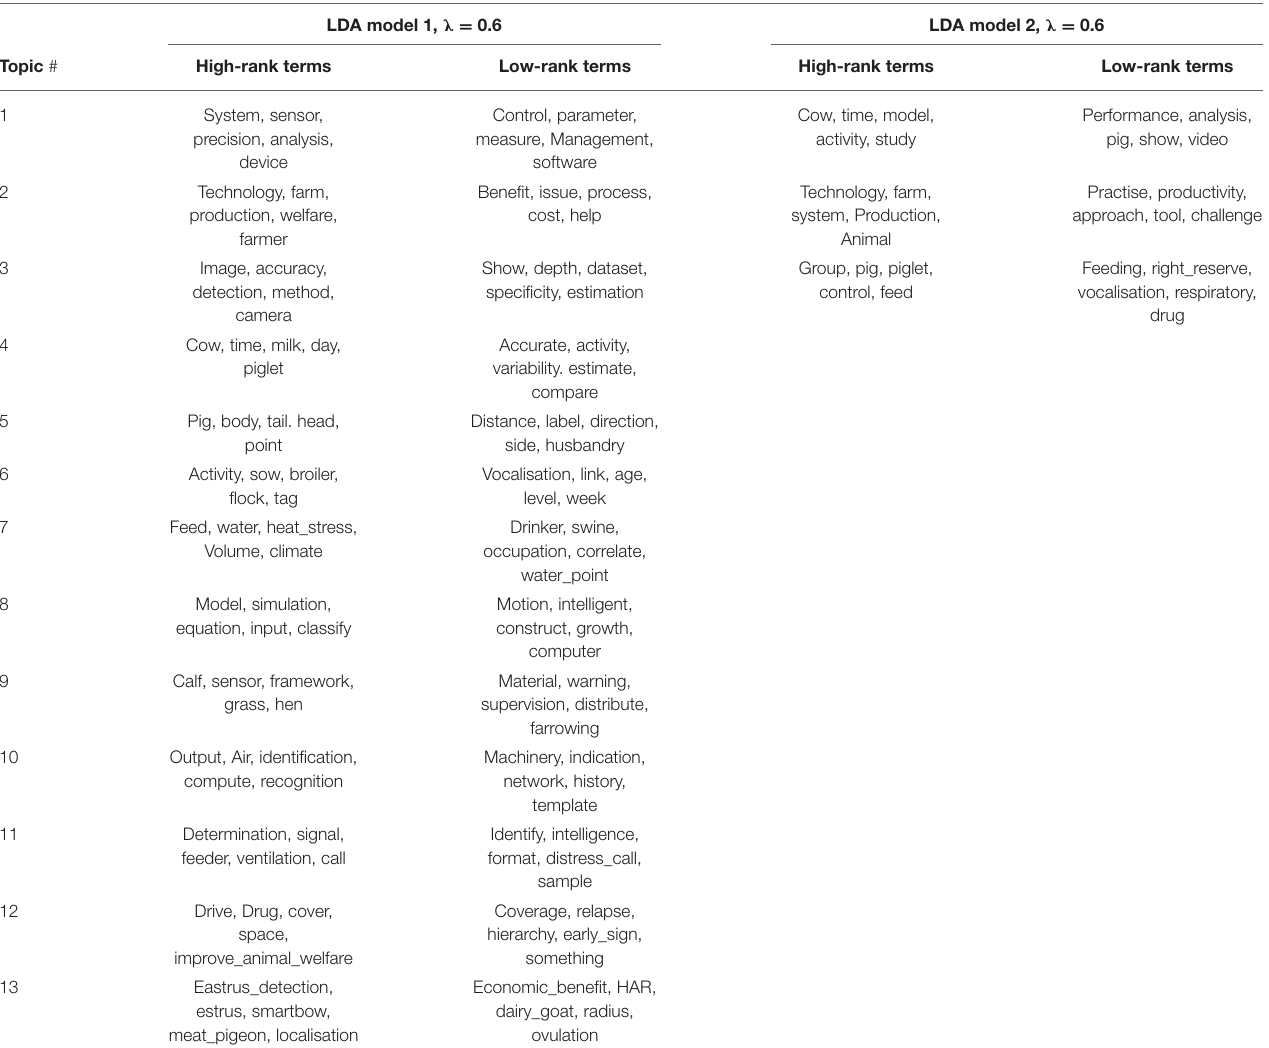
TABLE 2 | Per-topic term overview of LDA Model 1 and LDA Model 2 with only 5 highest and 5 lowest ranked terms from each topic displayed. LDA model 1, λ =